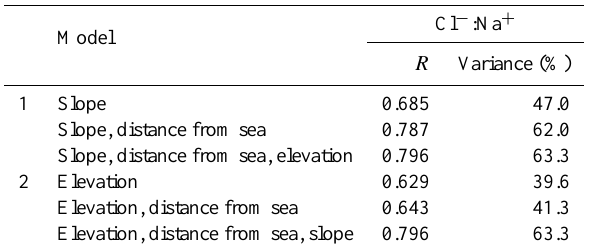
Table 4. Multiple regression model summaries explaining the per- centage of Cl − /Na + variability attributed to the physical parame- ters. Model 1 shows the variance due to slope entered in the regres- sion equation followed by distance from sea and elevation while model 2 shows the variation due to elevation, followed by distance from sea and